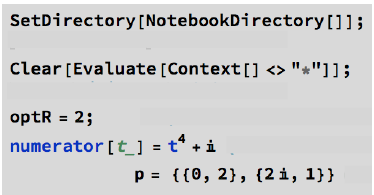
Figure 4. Part of the structure of the [SInt] algorithm corresponding to the Option 2 to input r .